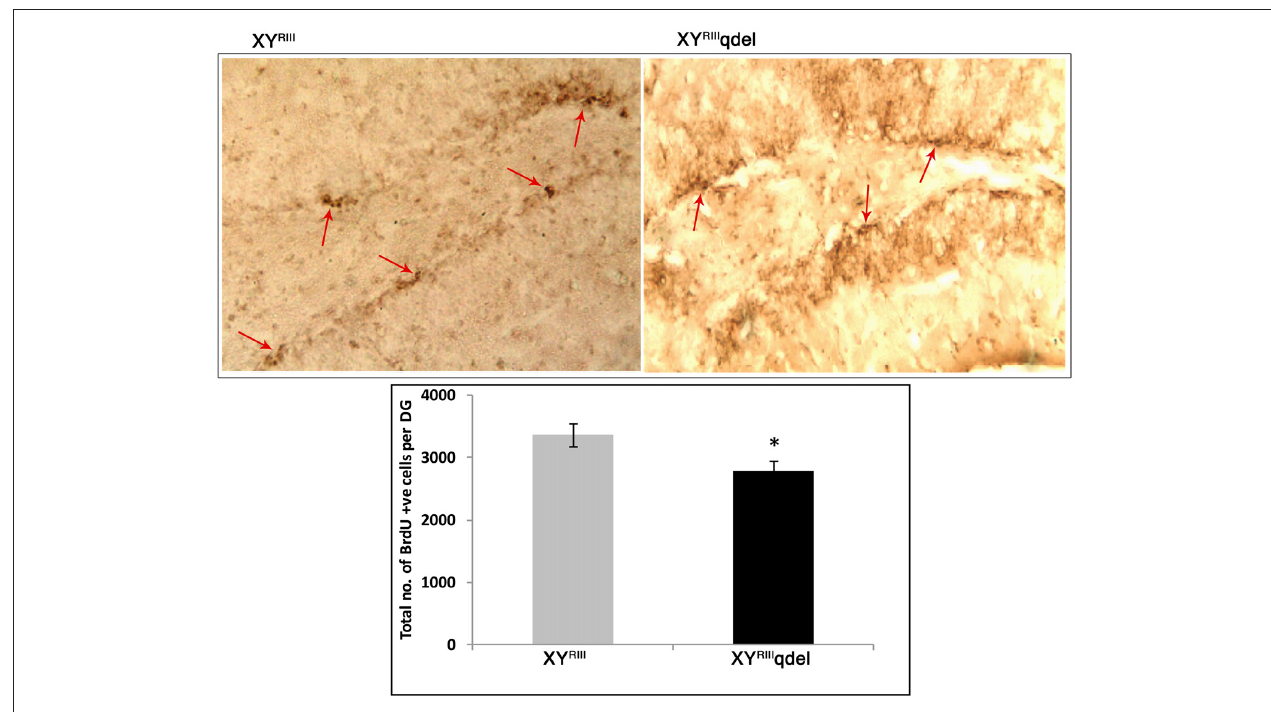
FIGURE 7 | Hippocampal neurogenesis in XY RIII qdel and wild type mice. Number of BrdU-positive cells in the sub-granular zone of the dentate gyrus. Upper panel shows representative photomicrographs and lower panel shows the actual counting ( n = 4–5/group) ∗ P < 0.05.